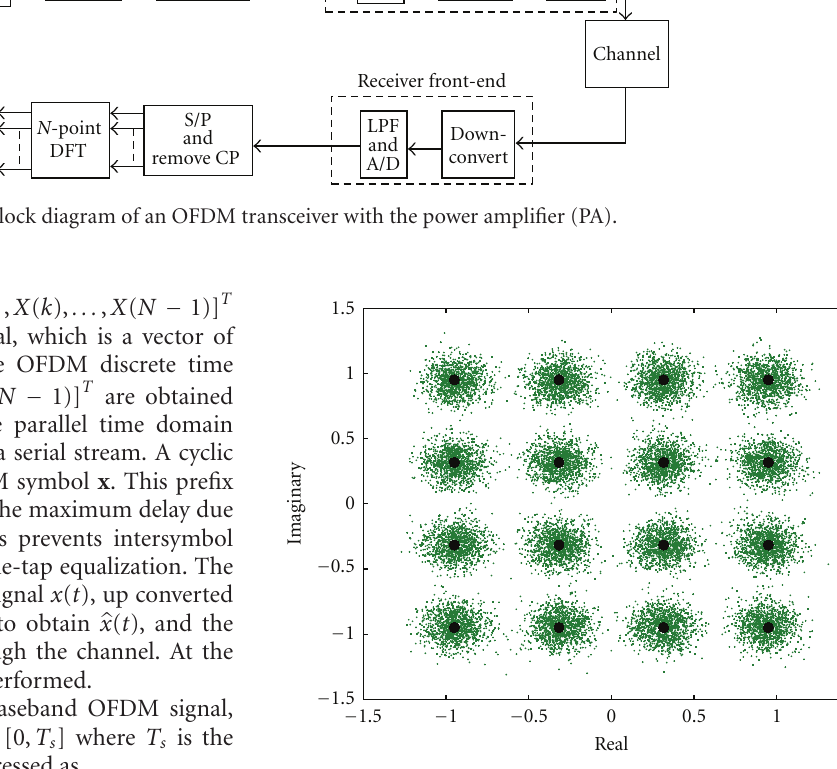
Figure 2: E ff ect of clipping noise on the received OFDM signal for 1000 OFDM symbols with a 16-QAM constellation, N = 256, IBO =